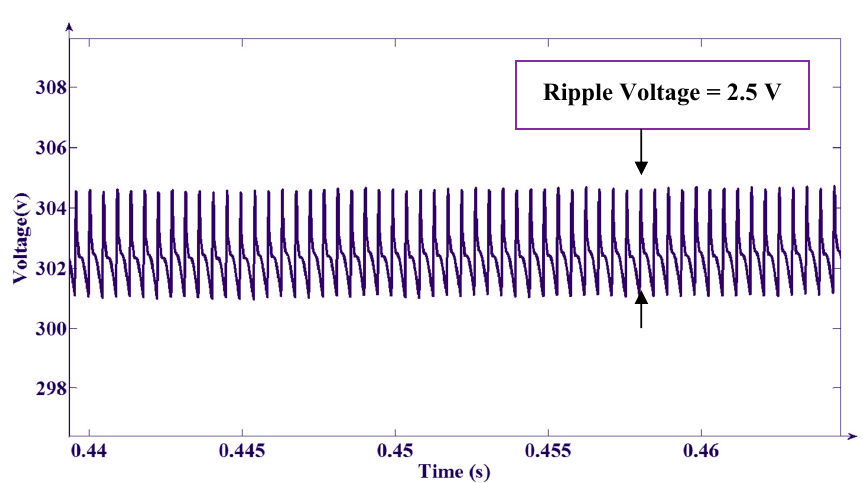
Figure 49. Output voltage waveform for hybrid controller-3-based BDC.